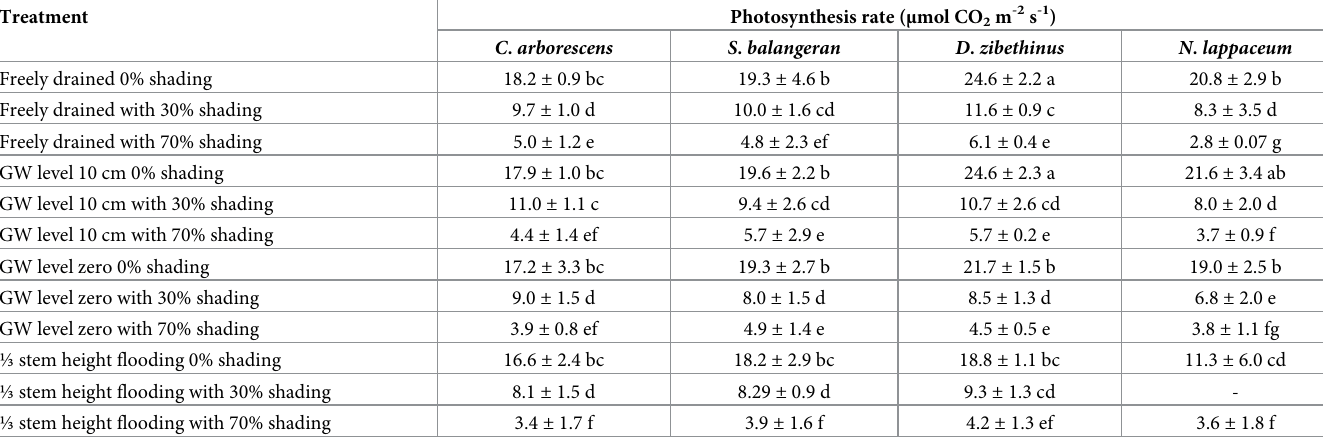
Table 8. Photosynthesis rate of four plant species under different level of inundation and